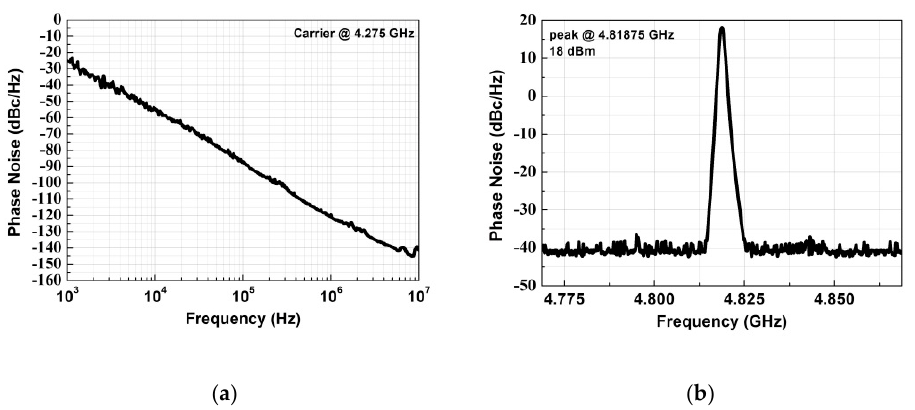
Figure 8. Measured ( a ) PN at the carrier frequency of 4.27 GHz and ( b ) P out at 4.8 GHz of the switched inductor VCO.